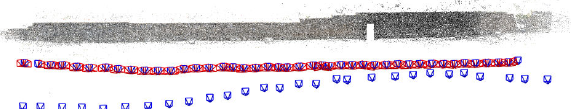
Figure 4. The terrestrial dataset Paestum Wall Full mixing normal (blue) and convergent (red) images.